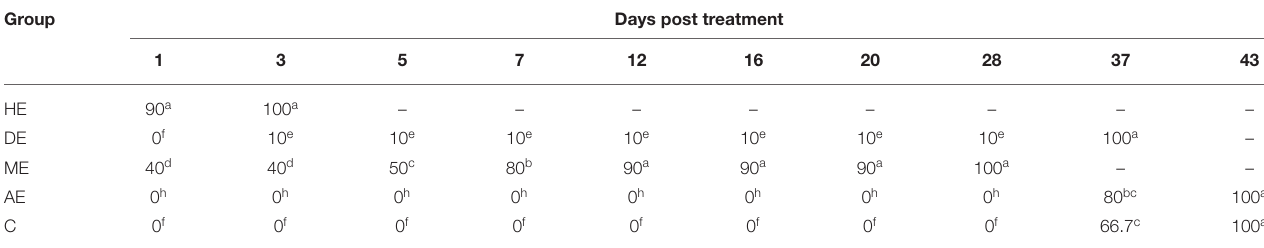
TABLE 3 | In vitro mortality rates of engorged Hyalomma dromedarii treated with 15% hexane, methanol, and dichloromethane extracts of neem seeds. Group Days post treatment